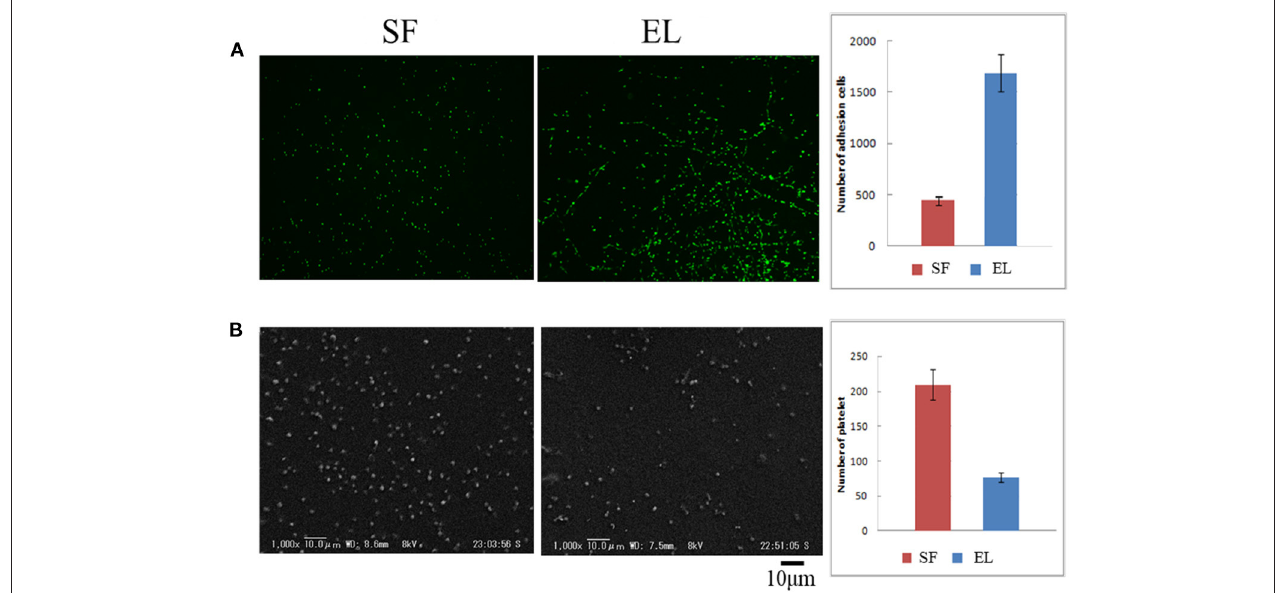
FIGURE 1 | (A) (left) Pictures of attachment of human umbilical vein endothelial cells on silk fibroin (SF) and elastin (EL)-coated 24-well plates. (right) The number of cell attachments shown as a histogram. (B) (left) Scanning electron microscope images of platelet adhesion on SF and EL-coated 24-well plates (right). The number of platelet attachments shown as a